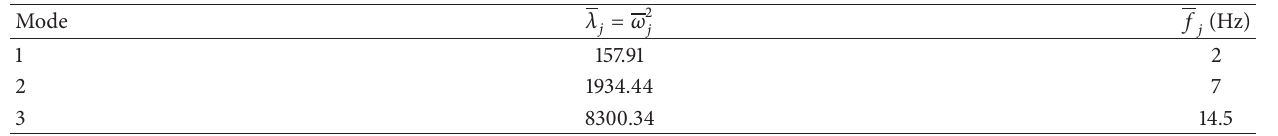
Table 15: Target frequencies (Case 3).